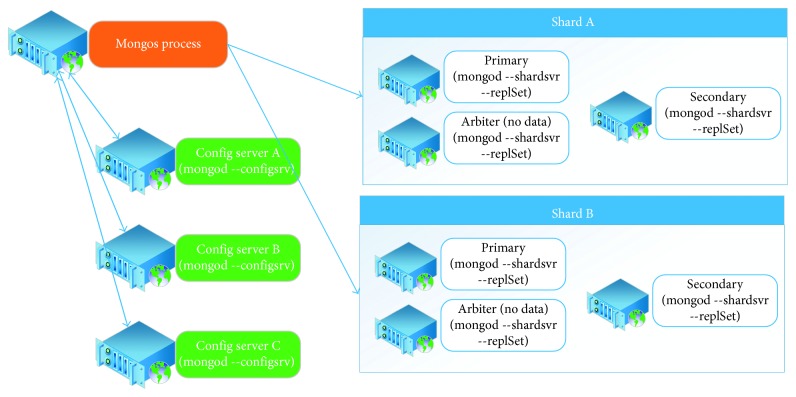
Sharded cluster method [28].